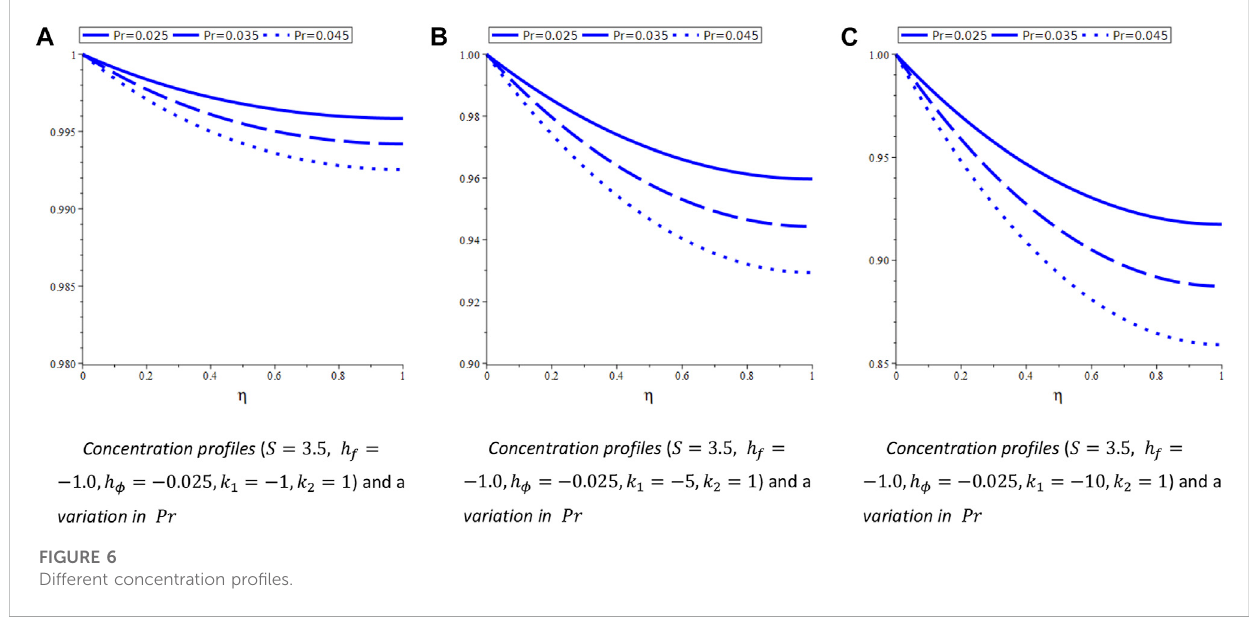
FIGURE 6 Different concentration pro fi